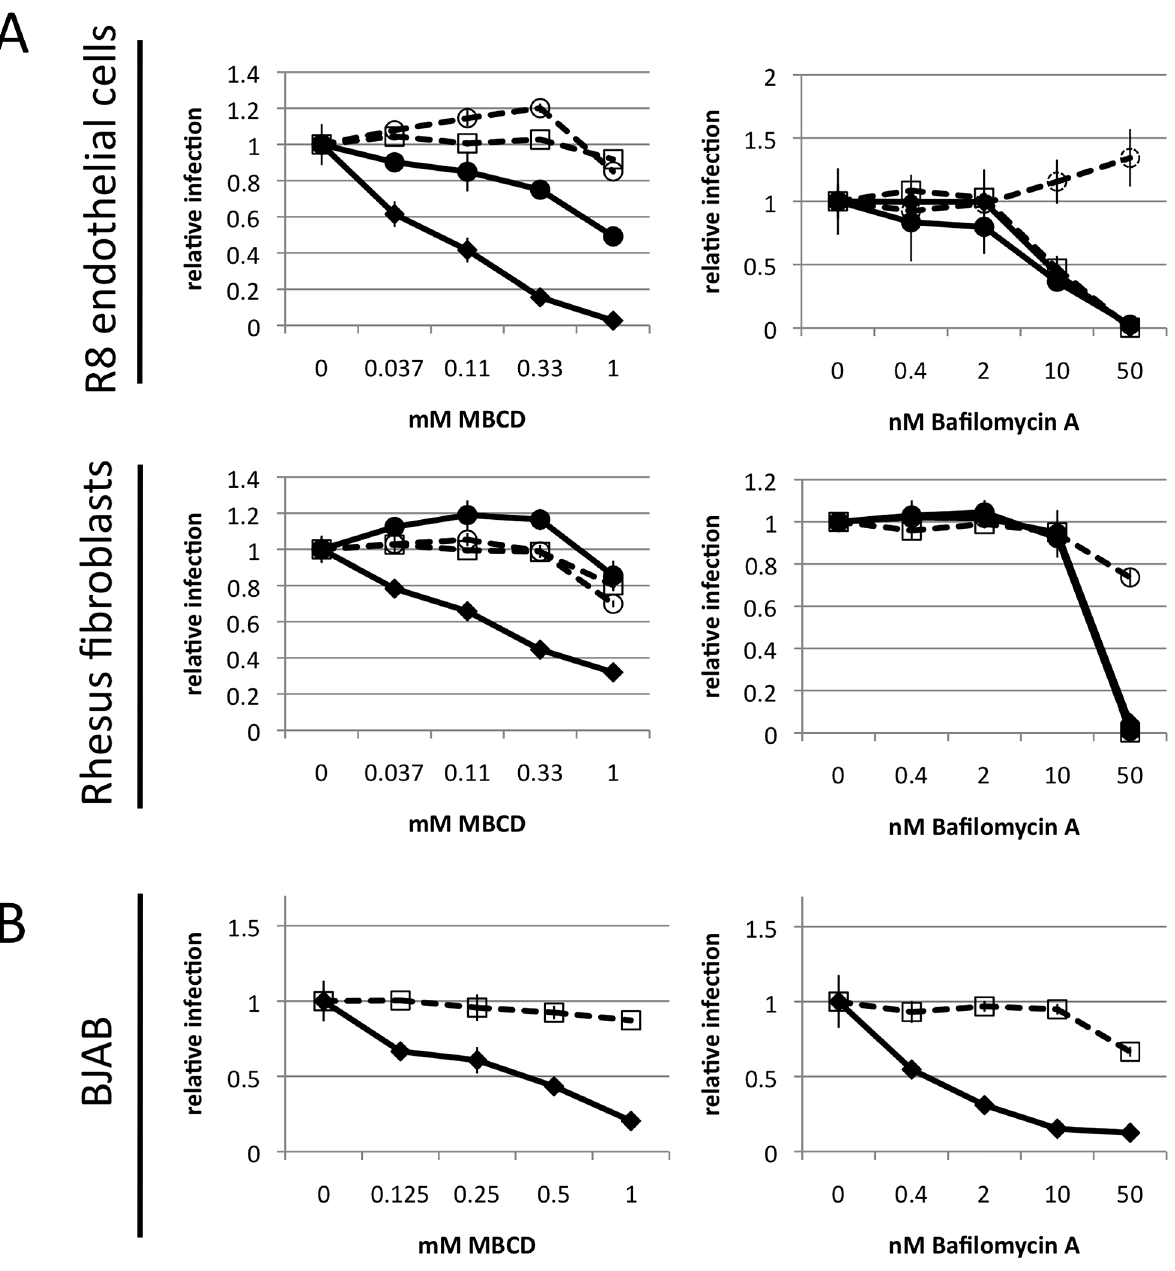
Figure 9. Rhadinovirus entry is dependent on vesicle acidification. ( A ) R8 endothelial cells or rhesus fibroblasts were pre-incubated for 1 h with MBCD or bafilomycin A at the indicated concentrations. The cells were then inoculated with rKSHV.219 (black line, circles) or RRV-GFP 26-95 (black line, diamonds). SIVmac329deltanef-GFP pseudotyped with A-MLV (dashed line, open circles) or VSV-G (dashed line, open boxes) envelope proteins was used in parallel as controls. Entry was assayed by GFP expression after 48 h. ( B ) The same assay as in (A) was performed with BJAB B cells with RRV-GFP 26-95 (black diamonds). An exclusion dye based cell viability assay (dashed line, open boxes) was included to control for toxicity. (n=3; error bars indicate